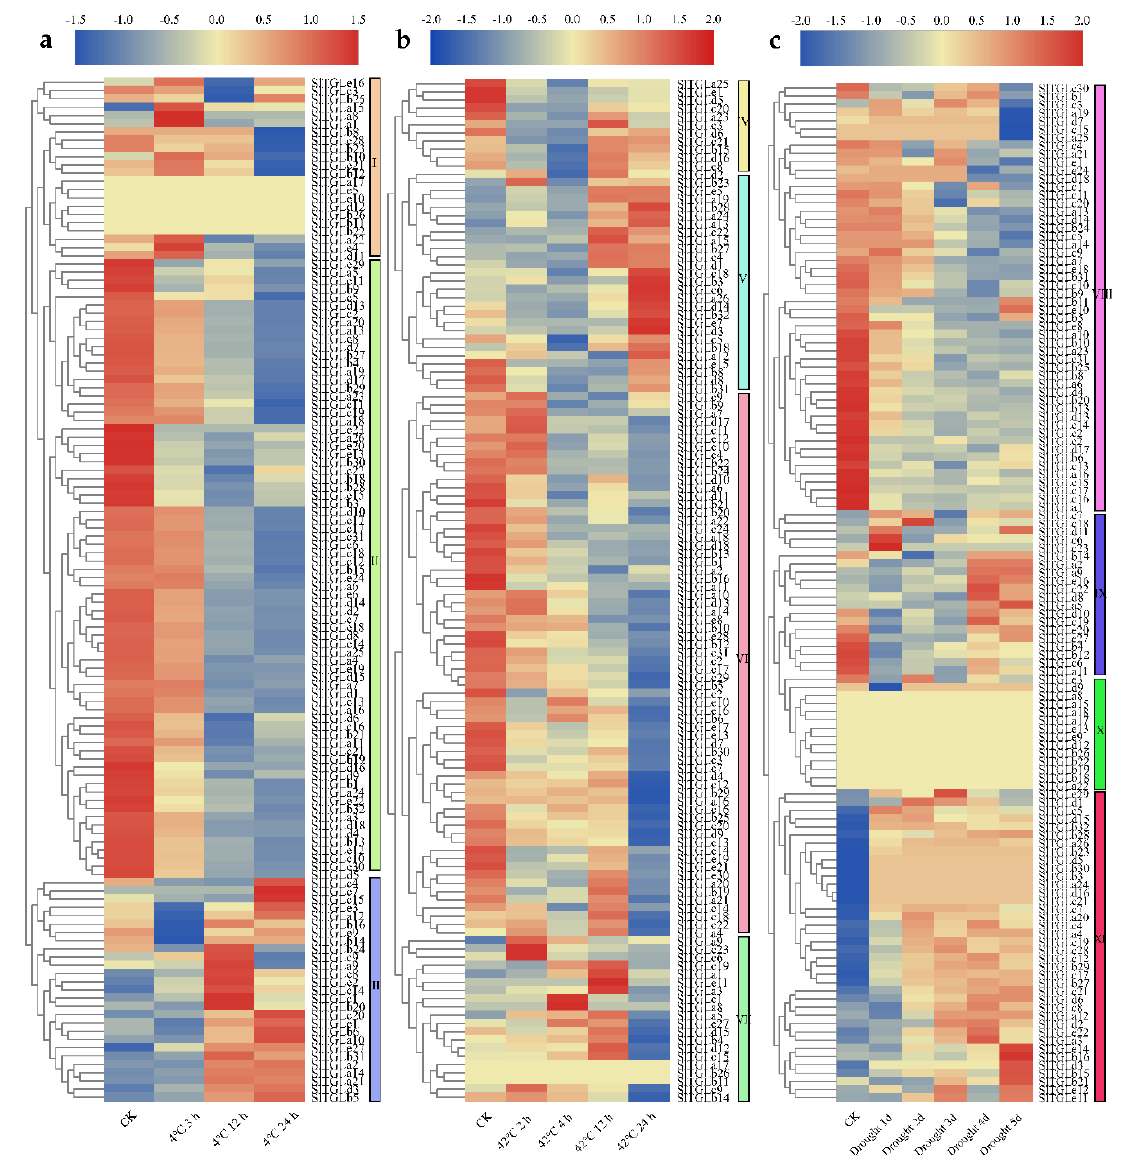
Figure 6. The expression profiles of SlTGL genes in chilling ( a ), heat ( b ), and drought ( c ) stress of S. lycopersicum cv. M82. ( a – c ) Heatmap of RNA-seq data of M82. Due to the differences in expression under different stresses, we re-clustered 129 genes according to their expression levels, and named the re-clustered groups from I to XI. Heatmaps of gene expression profiles were generated using TBtools [45]. Four-week-old tomato plants were treated with different abiotic stresses and leaf samples were collected for the RNA-seq analysis. CK refers to plants before stress treatments in each set. In the color gamut, the beige part represents the same amount of expression.